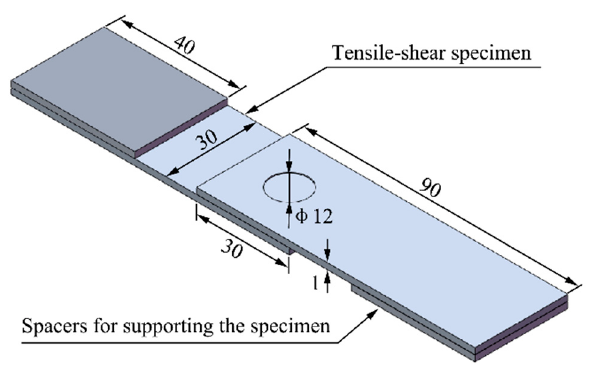
Figure 3. Con fi guration and size of the tensile–shear specimen (in mm).